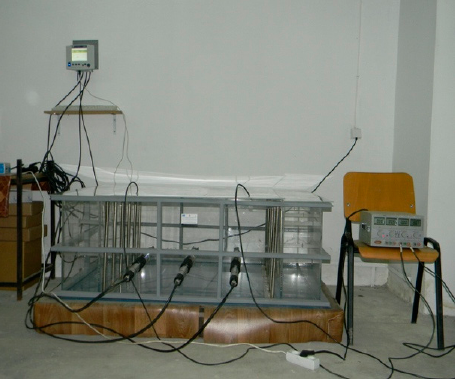
Figure 1. Pilot plant for electroremediation and the electrical and chemical combined treatment.